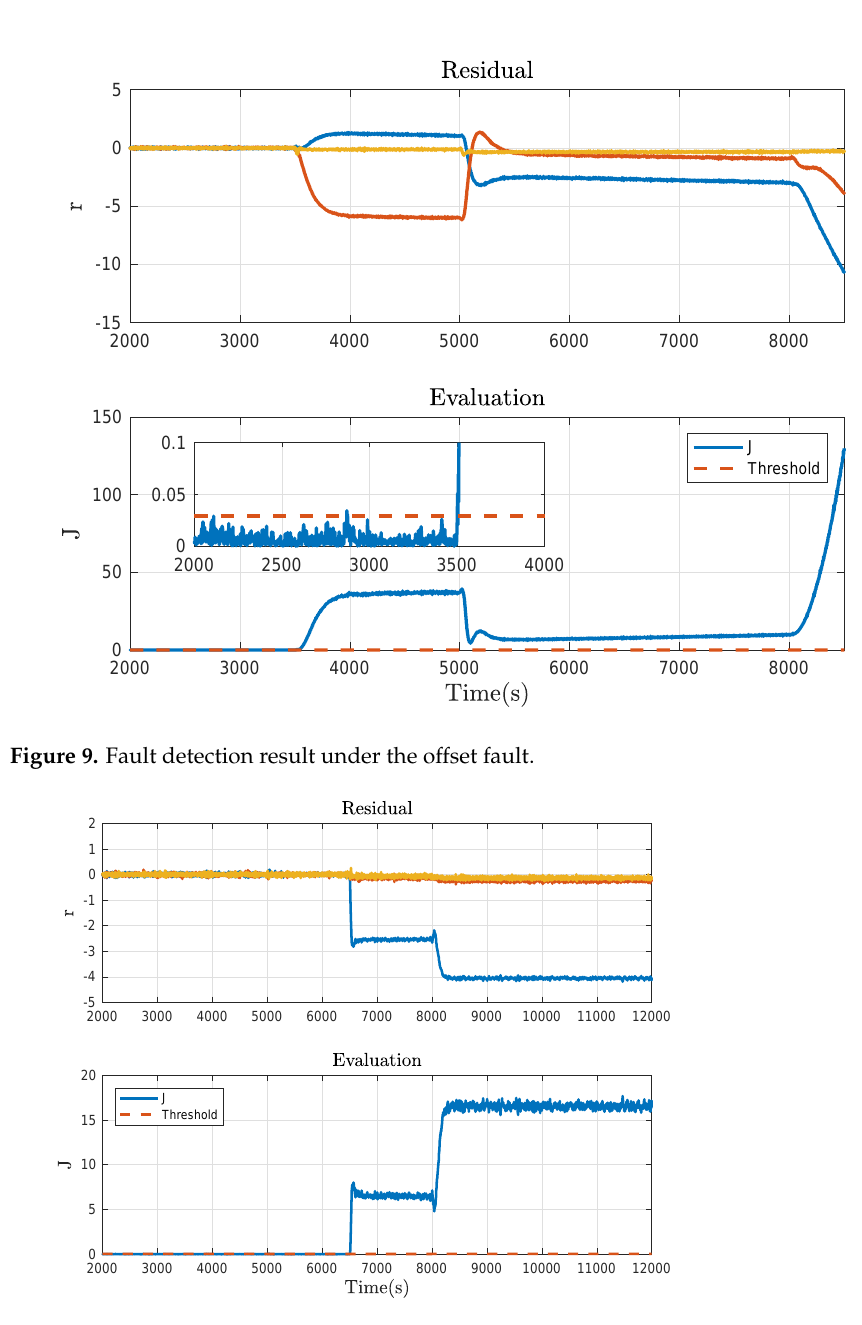
Figure 10. Fault detection result under the leakage